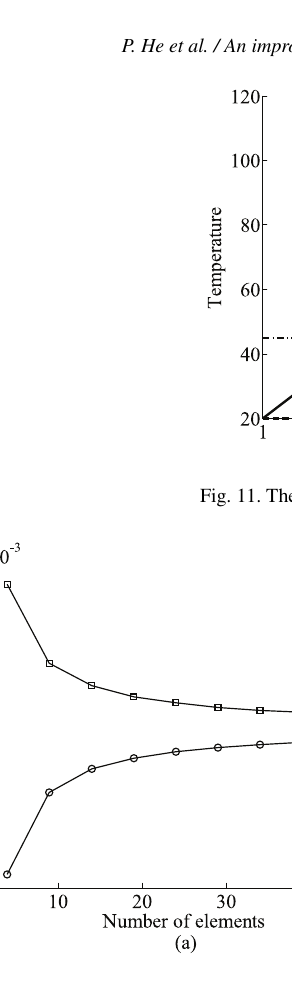
Fig. 12. The differences of the first two nature frequencies of the traditional beam element form the improved beam element. (a) The differences of the first nature frequencies; (b) The differences of the second nature